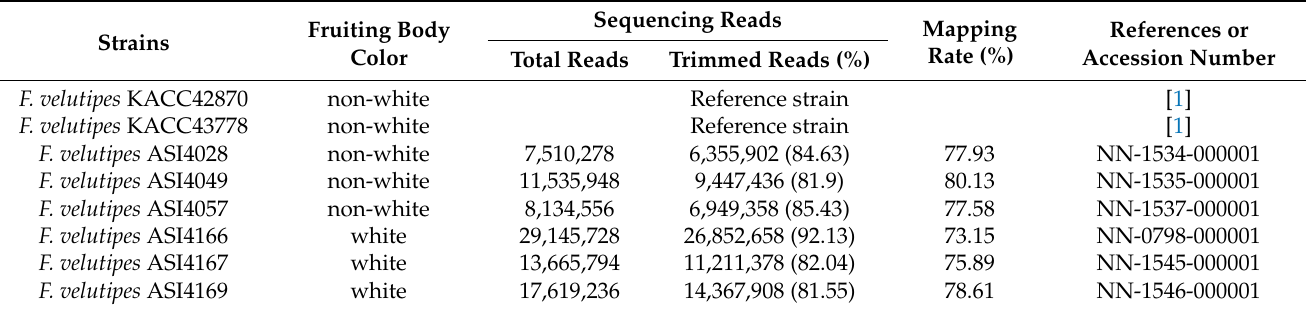
Table 3. List of Flammulina velutipes strains and genome sequencing statics.